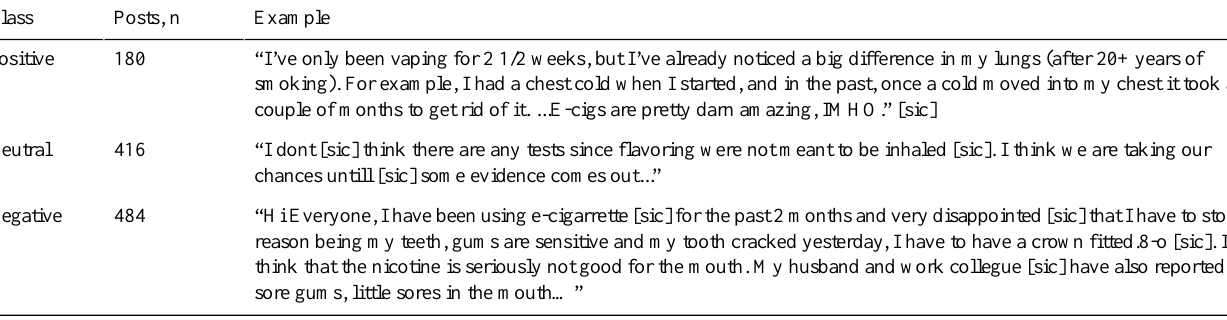
Table 1. Sample data summary.